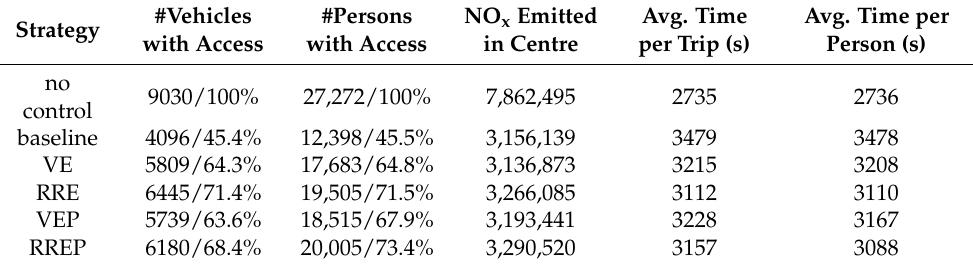
Table 4. Simulation results for pollution-based access with varying arrival